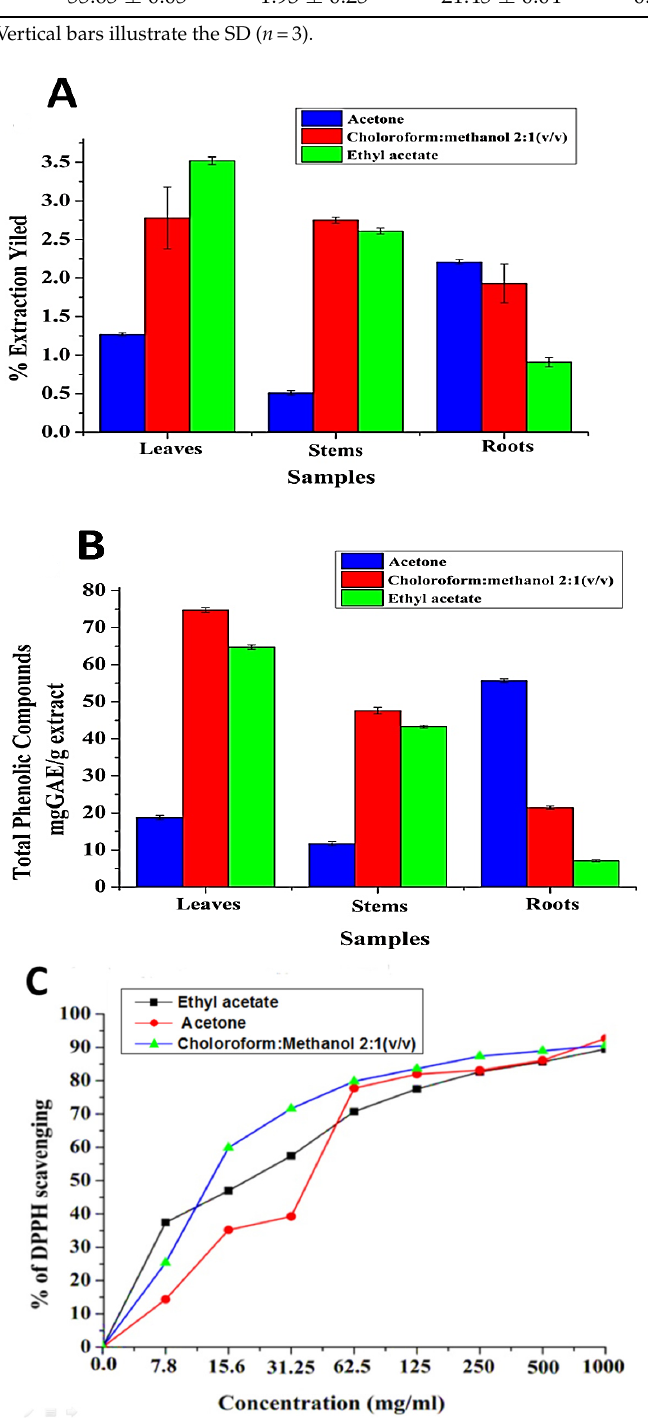
Figure 3. Effect of solvents on the recovery of ( A ) EY and ( B ) TPC of SRLe . The values are presented as means ± SD ( n = 3). ( C ) Scavenging activity on DPPH radicals